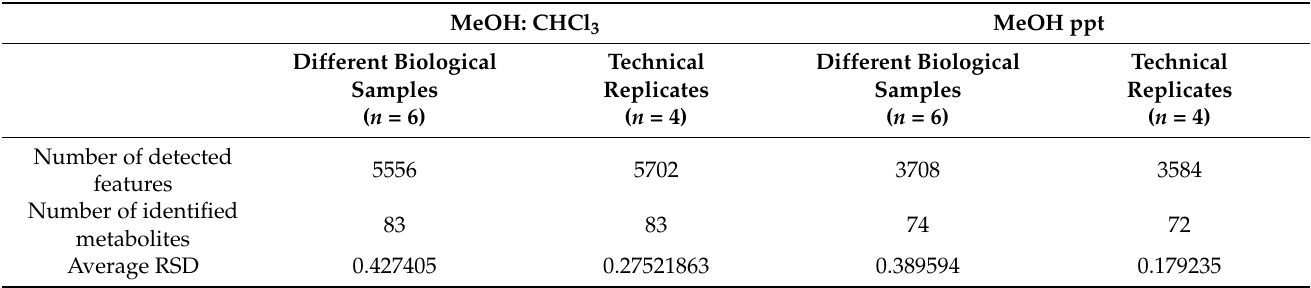
Table 1. Comparing numbers of identified metabolomics features and their average variation.